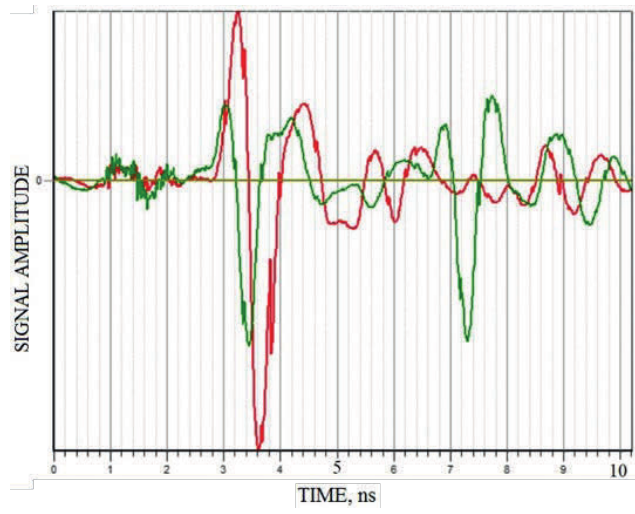
Fig. 6. Graphs of signals with noise and distortion.